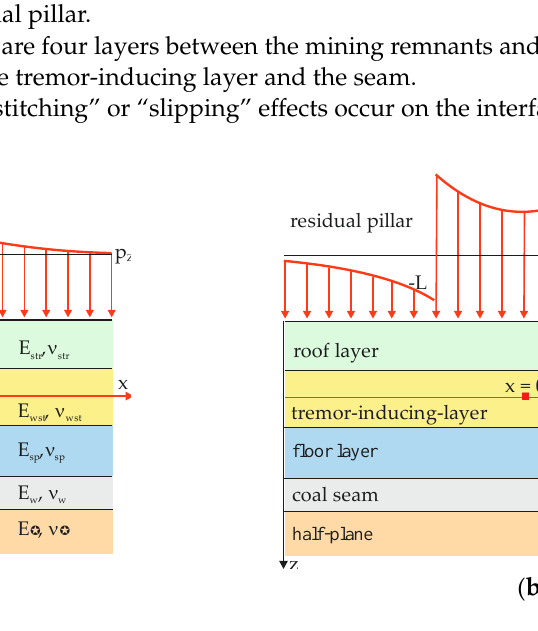
Figure 3. Modelled impacts of: ( a ) exploitation edge and ( b ) residual pillar on the multi-layer medium including the tremor-inducing layer.